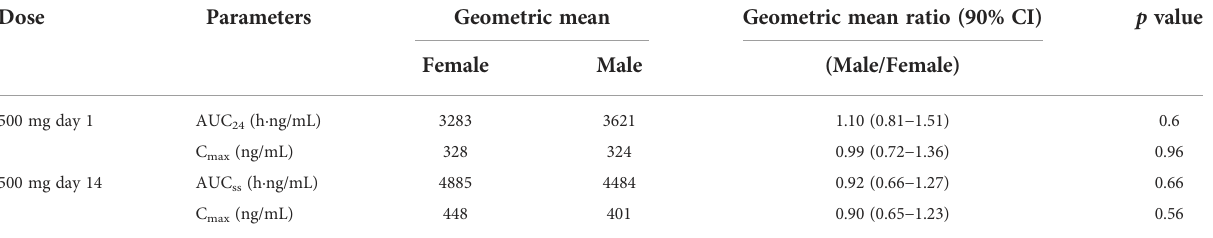
TABLE 3 Pharmacokinetic parameters of apatinib in male and female patients at 500 mg day 1 and day 14.